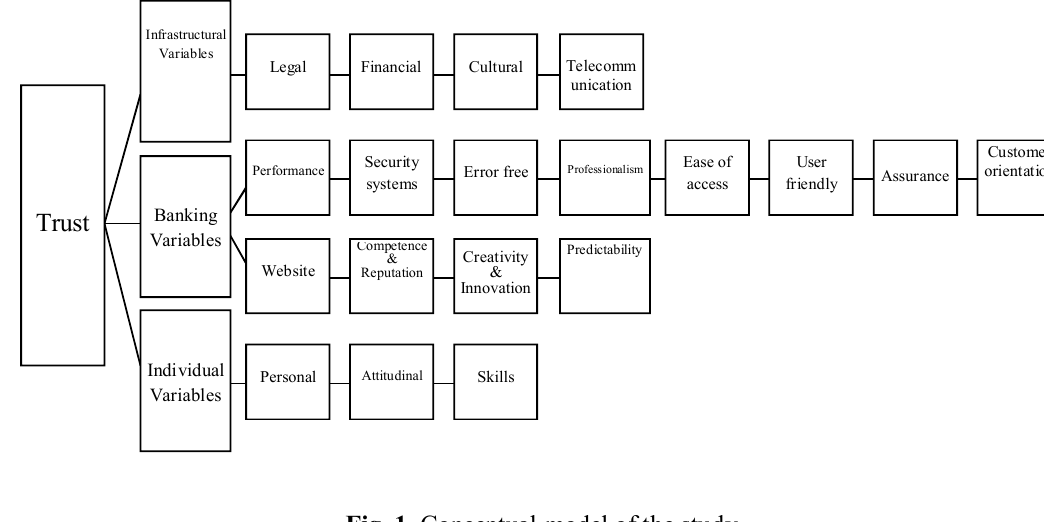
Fig. 1. Conceptual model of the study (Adapted from Wendy et al.